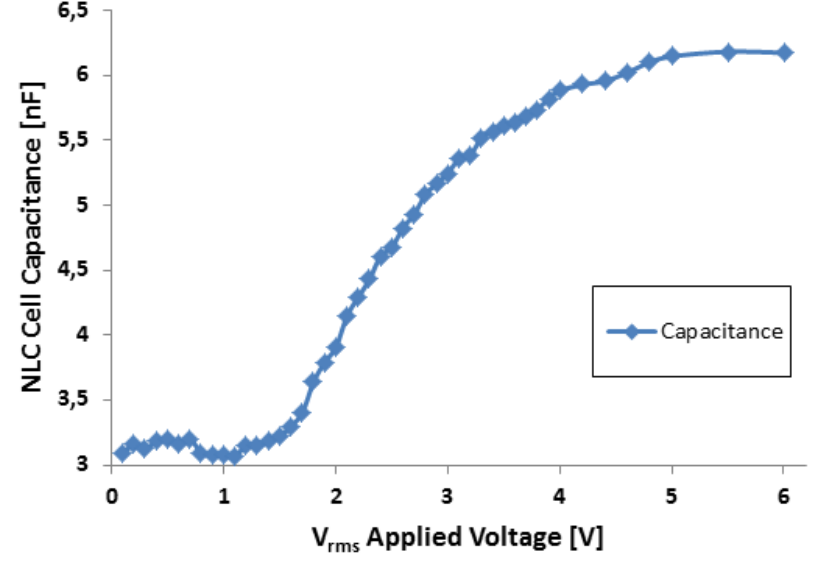
Figure 5. Equivalent capacitance of the NLC cell used in the T-f